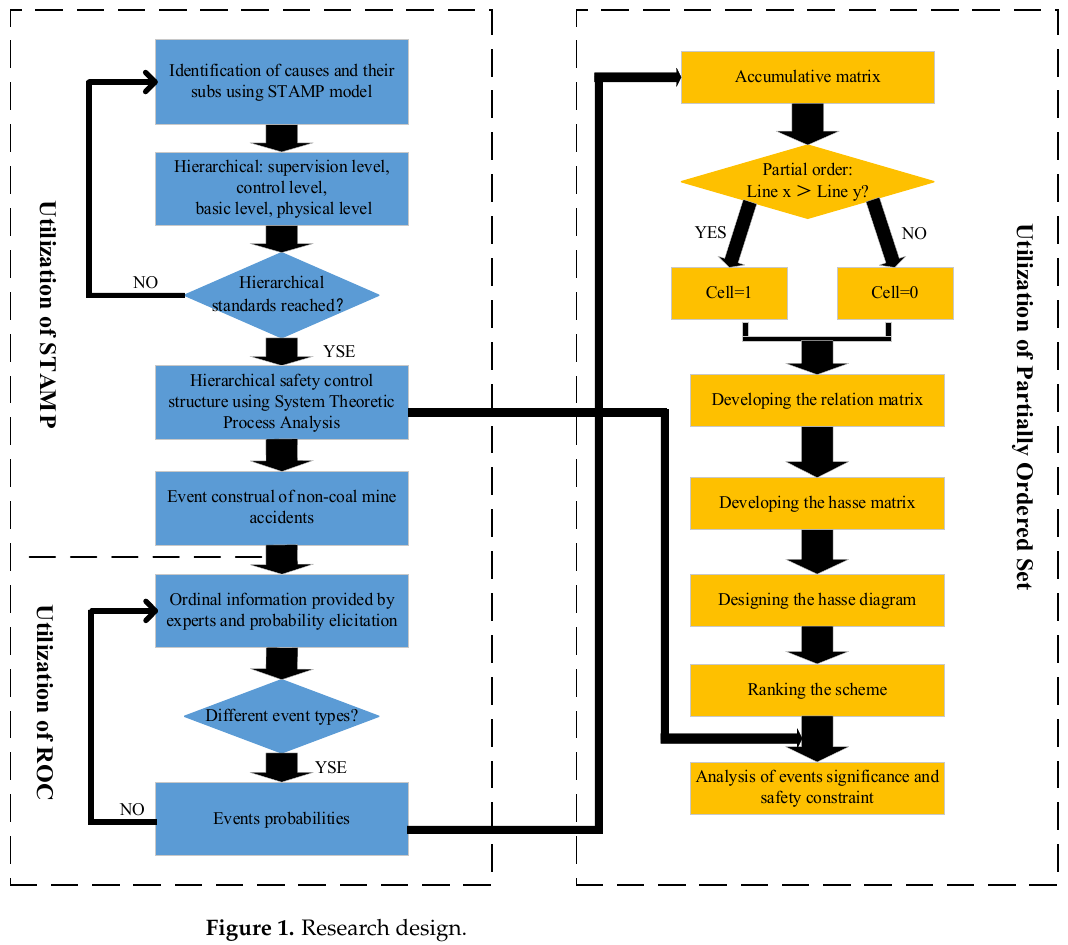
Figure 1. Research design.